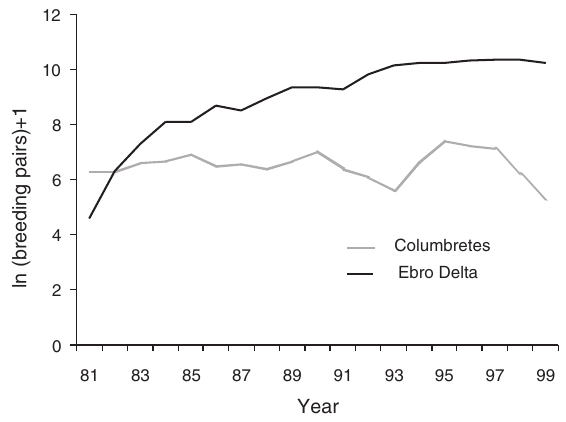
F IG . 2. – Local population growth at two neighbouring colonies of Audouin’s gull in the western Mediterranean: the Ebro Delta (solid line) and the Columbretes Islands (dashed line).